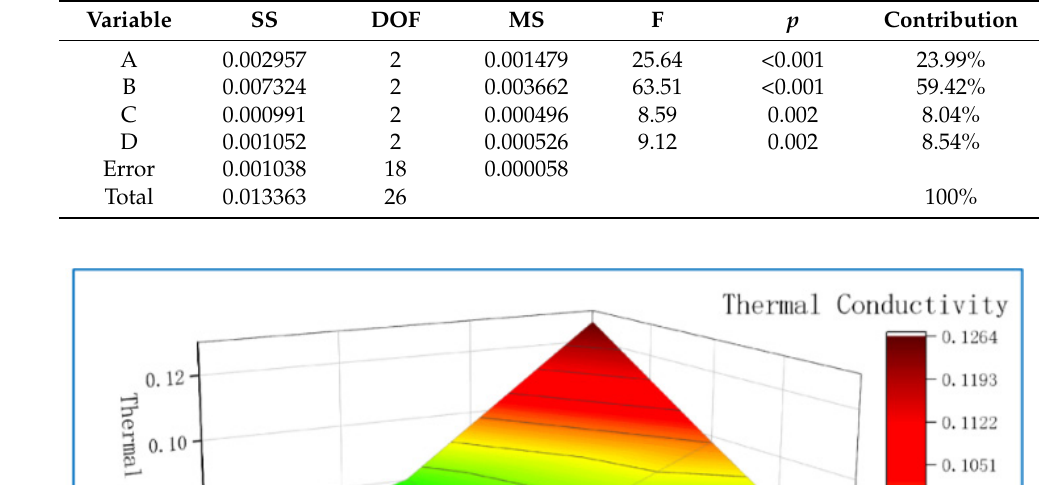
Table 6. ANOVA result for the thermal conductivity.